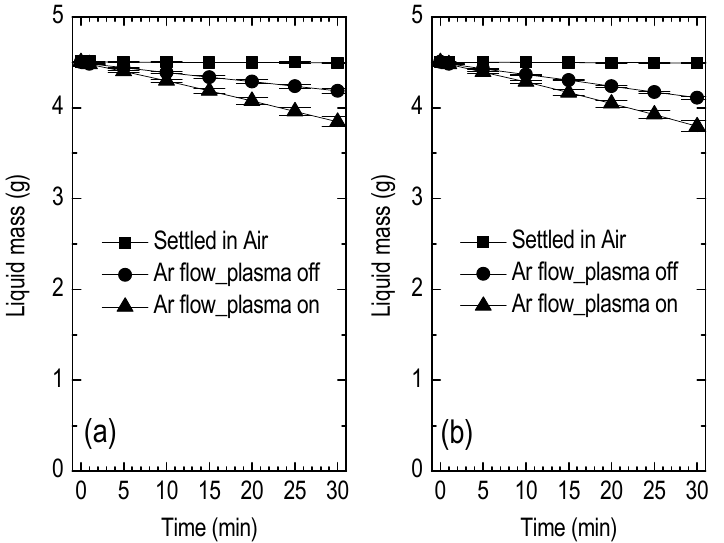
Figure 8. Liquid mass evolution versus time in the case of ( a ) DDW and ( b ) PBS. Three different scenarios are examined: (i) liquid settled in ambient air; (ii) liquid is impinged by Ar flow only; (iii) liquid is impinged by Ar plasma jet. Mean values and standard deviations are calculated from 3 series of experiments carried out on different dates. Operating conditions: 11 kV pp , 17.5 kHz, and 1.5 slm.